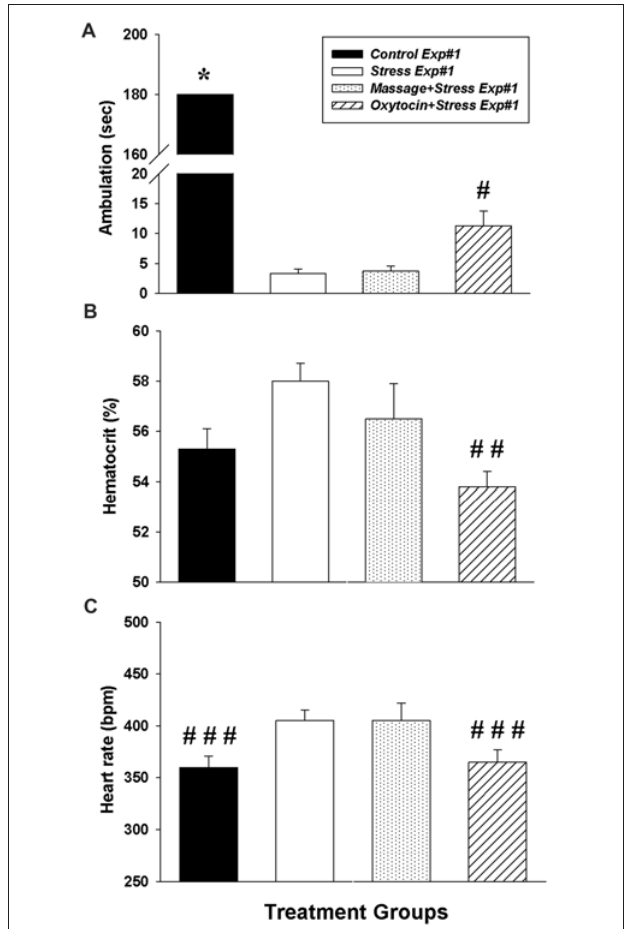
FIGURE 1 | Impact of intranasal oxytocin administered 5 min after (Experiment #1) daily foot shock sessions (3 days, 40 shocks/day, 8 mA/shock). (A) Ambulation (inverse of freezing behavior) during 3 min re-exposure to the fear conditioning chamber 7 days after the last day of foot shock. (B) Hematocrit levels (indirect assessment of blood pressure) taken 14 days after the last day of foot shock. (C) Resting heart rate monitored 14